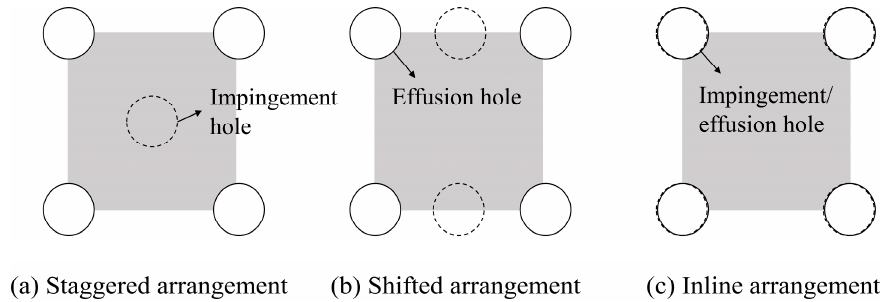
Figure 19. Three typical arrangement units of effusion and impingement holes.